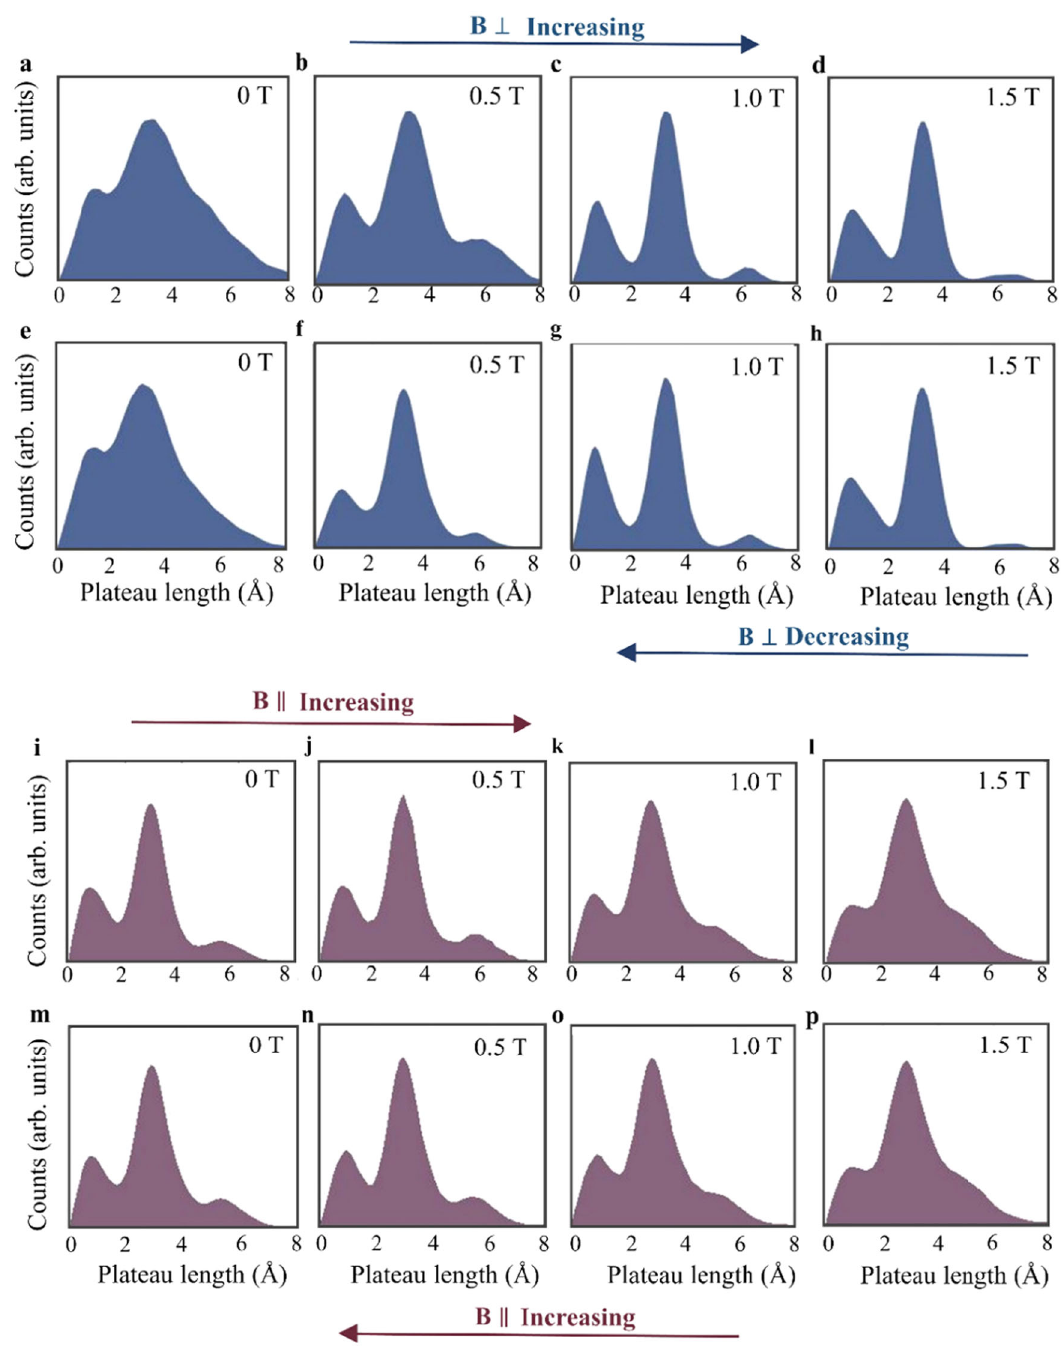
Fig. 3 Magnetic fi eld effect on the less-stable con fi gurations of Pt atomic wires. a – h Length histograms based on 10,000 traces recorded consequently as a function of increasing ( a – d ) and decreasing ( e – h ) magnetic fi eld perpendicular to the junction axis. The peaks ’ sharpness reversibly increases with the applied magnetic fi eld strength. i – p Similar measurements as a function of parallel magnetic fi eld. In contrast to the former case, here the peaks ’ sharpness decreases reversibly with increasing magnetic fi eld strength. Length histograms with varied sharpness can be obtained at zero magnetic fi eld by using different samples. We deliberately chose histograms with different sharpness at zero magnetic fi eld to clearly present the (de)sharpening effect. A complementary analysis is presented in Supplementary Section 8, based on histograms of similar zero- fi eld sharpness, allowing for a convenient quantitative comparison. We note that a similar analysis of Au wires control measurements (Supplementary Section 4) reveals no response to parallel magnetic fi eld, whereas a slight increase in the peaks ’ width is found for a perpendicular fi eld. This effect will be further analyzed for a perpendicular fi eld and at a shorter length ( d || ) for a parallel when applying a parallel fi eld. This implies a higher probability of fi eld, with a similar in fl uence on the in fl ection point of the energy reaching the breaking force under a perpendicular fi eld before curve (Fig. 4a). Figure 2g, h reveal that the formed wires are reaching the force needed to pull an atom from the electrodes, shorter when a perpendicular magnetic fi eld is applied and longer and vice versa for a parallel applied fi eld. In the force curve